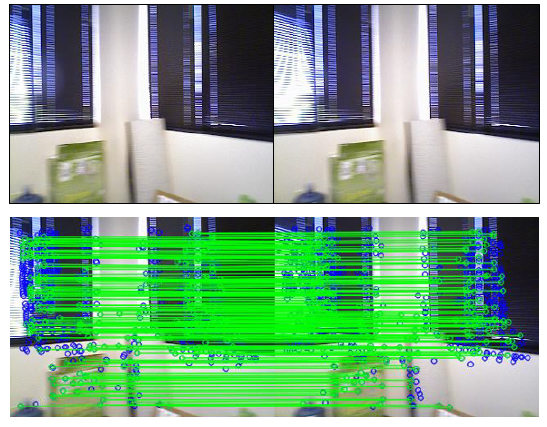
Two blurred images (top) and feature matching result (bottom) from our scanned RGB-D data from a real scene using a fast-moving camera.